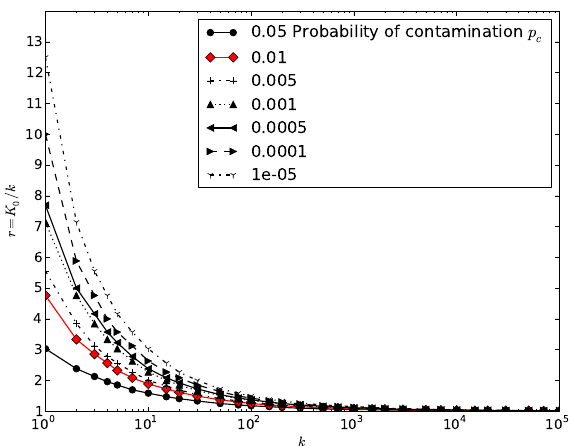
Figure 1. The ratio K 0 /k as a function of k , the minimum number of bootstrapped entries needed for the statistic in question, for lev- els of probability of contamination ranging from 10 − 5 (uppermost curve) to 0 . 05 (lowermost curve). The curve representing 1% prob- ability of contamination is marked in red (with diamonds) as it is a reasonable confidence level.